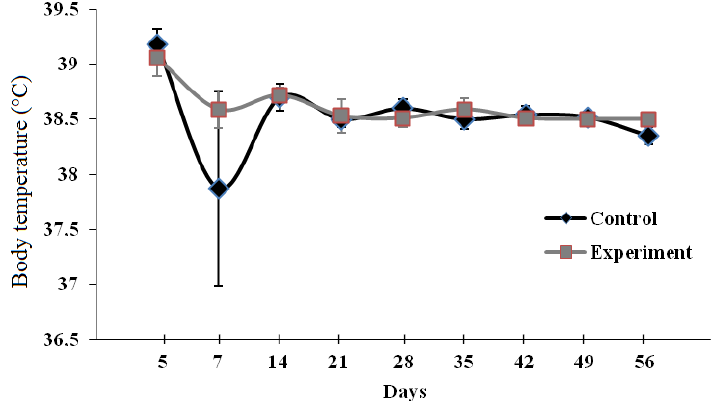
Figure 2. Mean (±standard error of the mean) body temperatures of control (CG, n = 10) and experimental (EG, n = 10) calves. CG, control group; EG, experimental